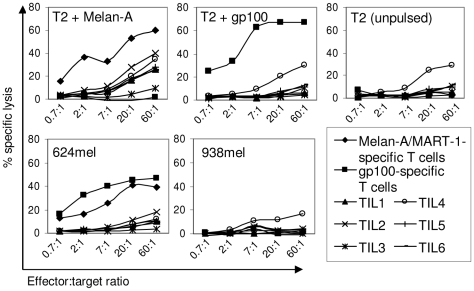
Cytotoxicity assay.Six TIL cultures derived from specimen M25 were assayed for cytotoxic activity against the indicated 51chromium-loaded target cells. Melan-A/MART-1- and gp100-specific T cell lines were used as positive controls.